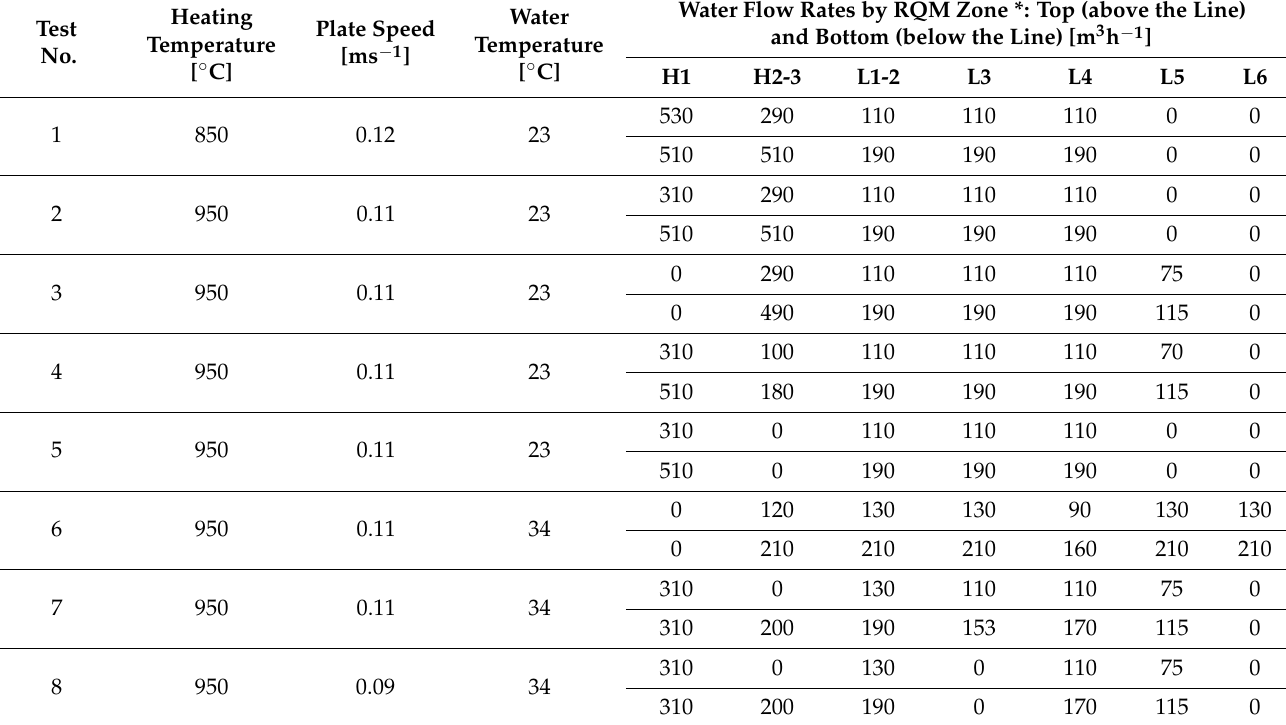
Figure 12. Thermocouple embedding scheme (dimensions are in mm). Of the five channels prepared, four were used in each test plate (details in the text). Table 1. Setpoint heating temperature and RQM operating regime in